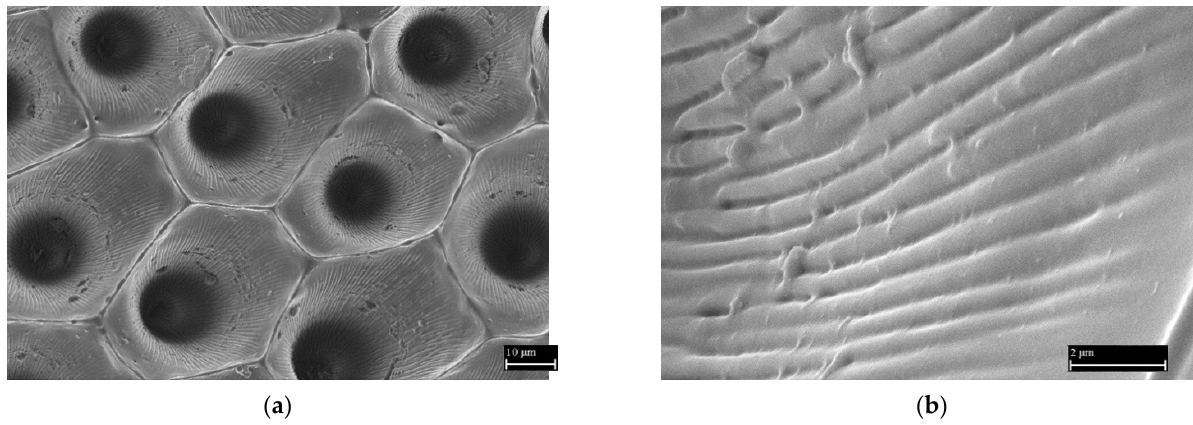
Figure 6. The surface of the elastomeric mold. ( a ) Overview microscopic image of the elastomeric mold—the first (negative) replica. ( b ) Detailed image of the mold surface. Reprinted from ref. [20].